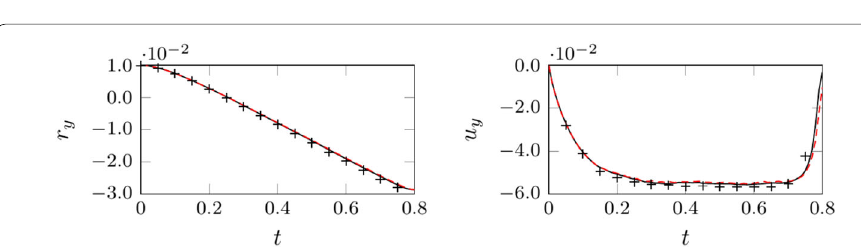
Fig. 10 A rigid circular disk falling in a fluid column: geometry and boundary conditions of the problem